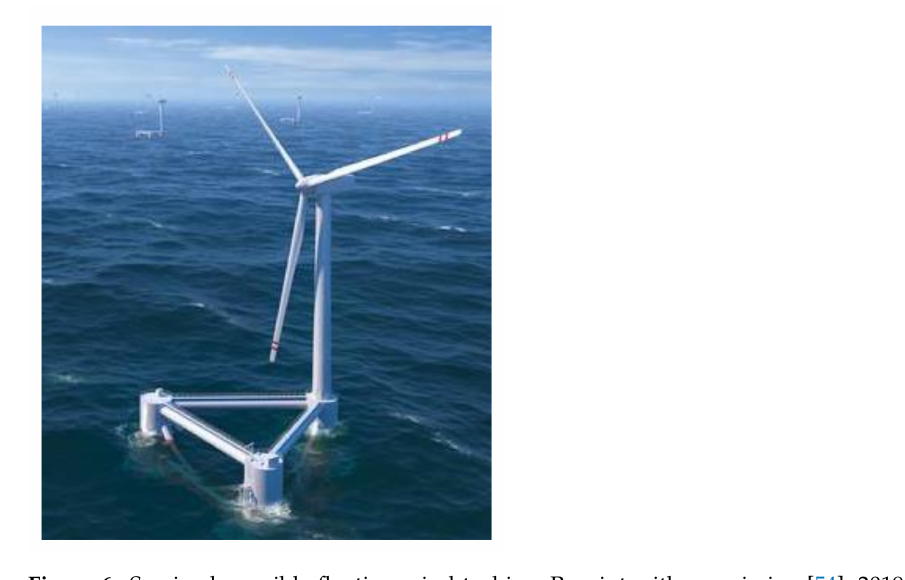
Figure 6. Semi-submersible floating wind turbine; Reprint with permission [54]; 2019, Principle